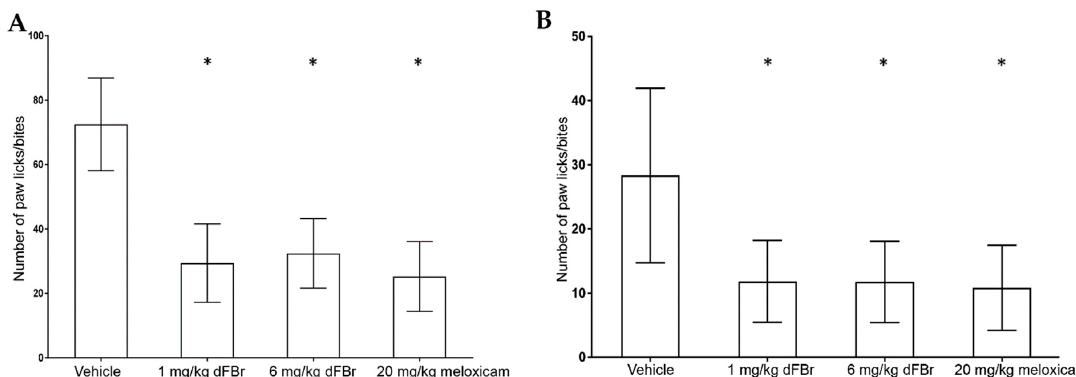
Figure 2. ( A ) Desformylflustrabromine (dFBr) significantly decreases the paw licks/bites in the early phase of the formalin test. The paw licks/bites are expressed as mean ( ± S.D.). Statistical significance was considered as * p < 0.05. Twelve mice were included in each treatment group ( n = 12). ( B ) dFBr significantly decreases the paw licks/bites in the late phase of the formalin test. The paw licks/bites are expressed as mean ( ± S.D.). Statistical significance was considered as * p < 0.05. Twelve mice were included in each treatment group ( n = 12).